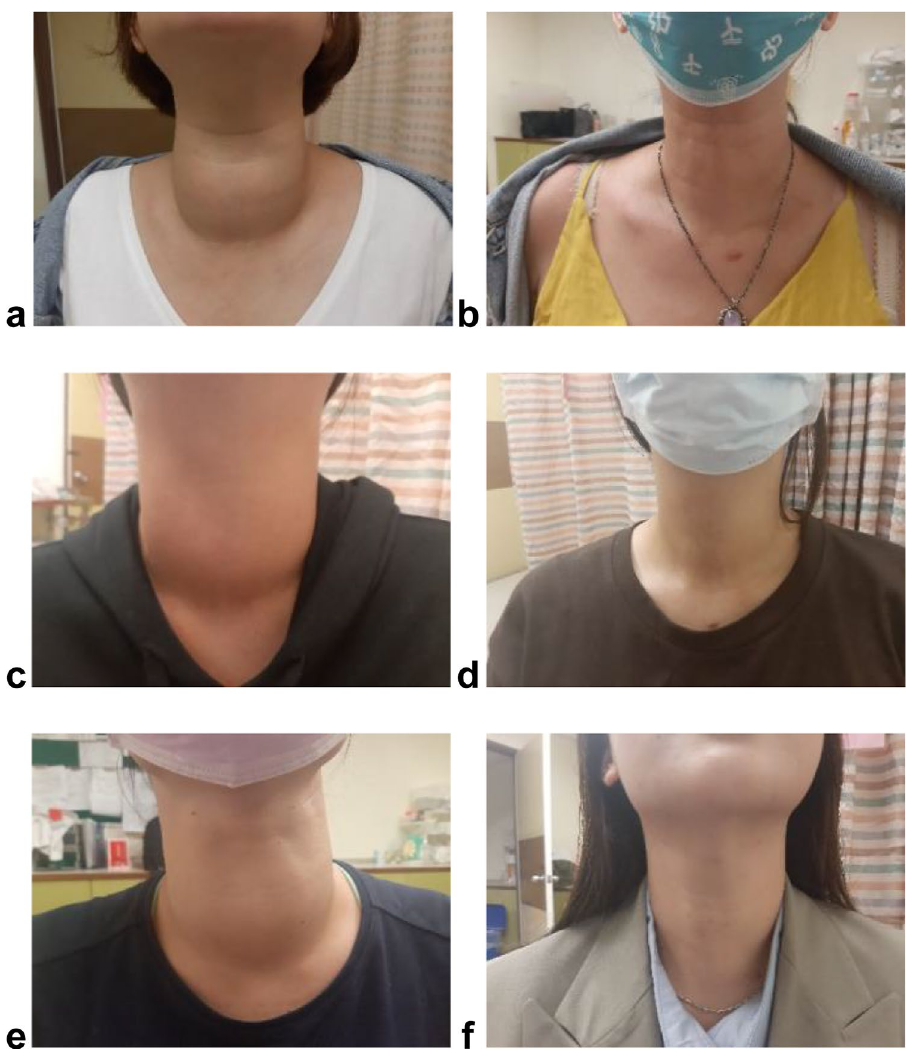
Figure 1. Photographs of large goiters. ( a , c , e ) Preoperative; ( b , d , f )